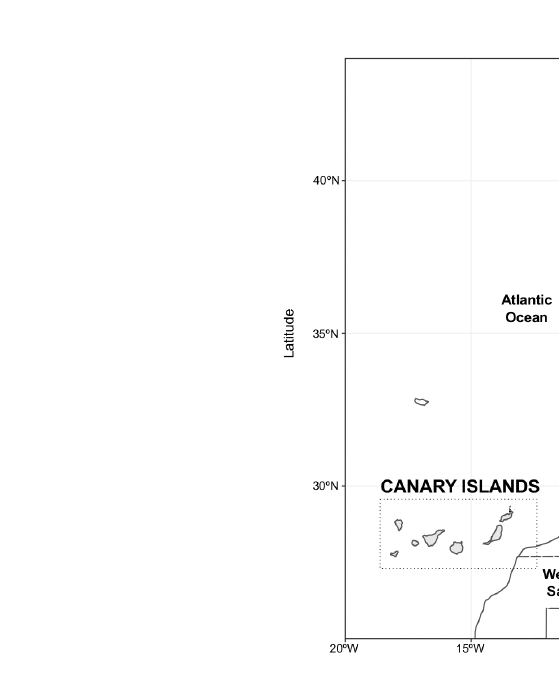
FIGURE 1 Geographical location of the Canary Islands with respect to the Iberian Peninsula and Northwest